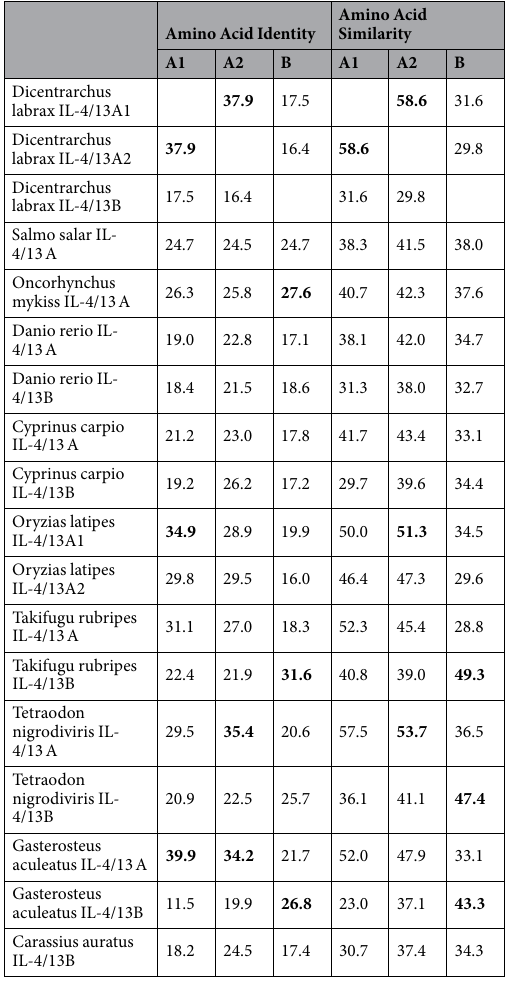
Table 1. Percentage of amino acid identity and similarity of sea bass IL-4/13 cytokines with selected IL-4/13 sequences from teleosts. The highest values are highlighted in